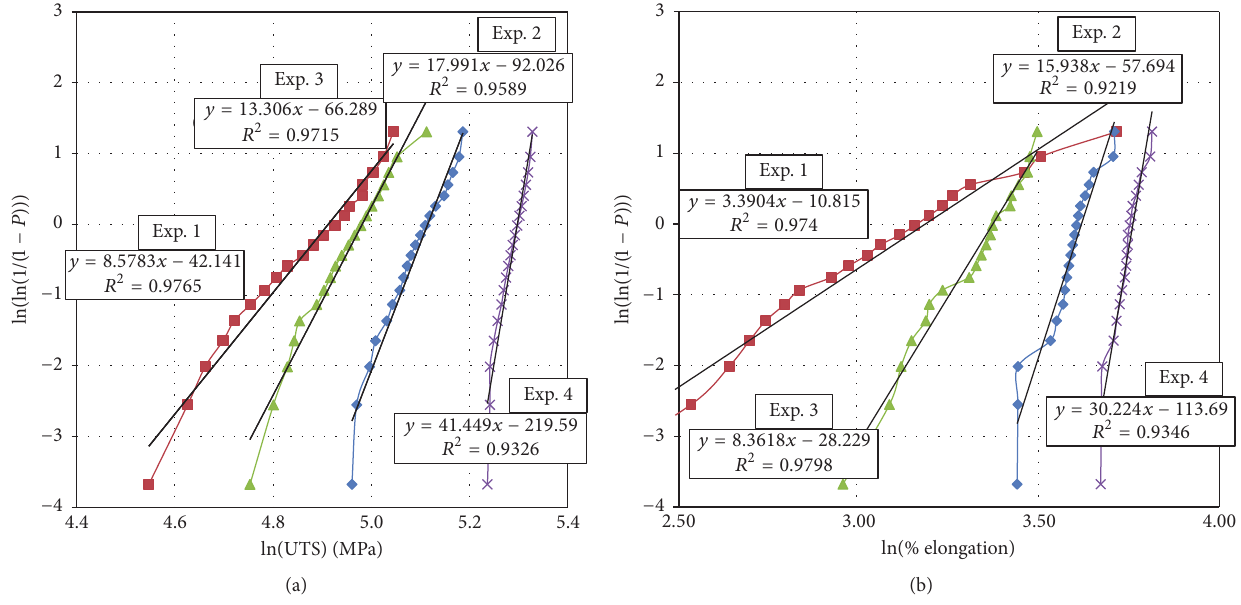
Figure 3: Weibull distribution of (a) ultimate tensile strength and (b) % elongation of Al-5Mg alloy specimens from different experiments listed in Table 1.